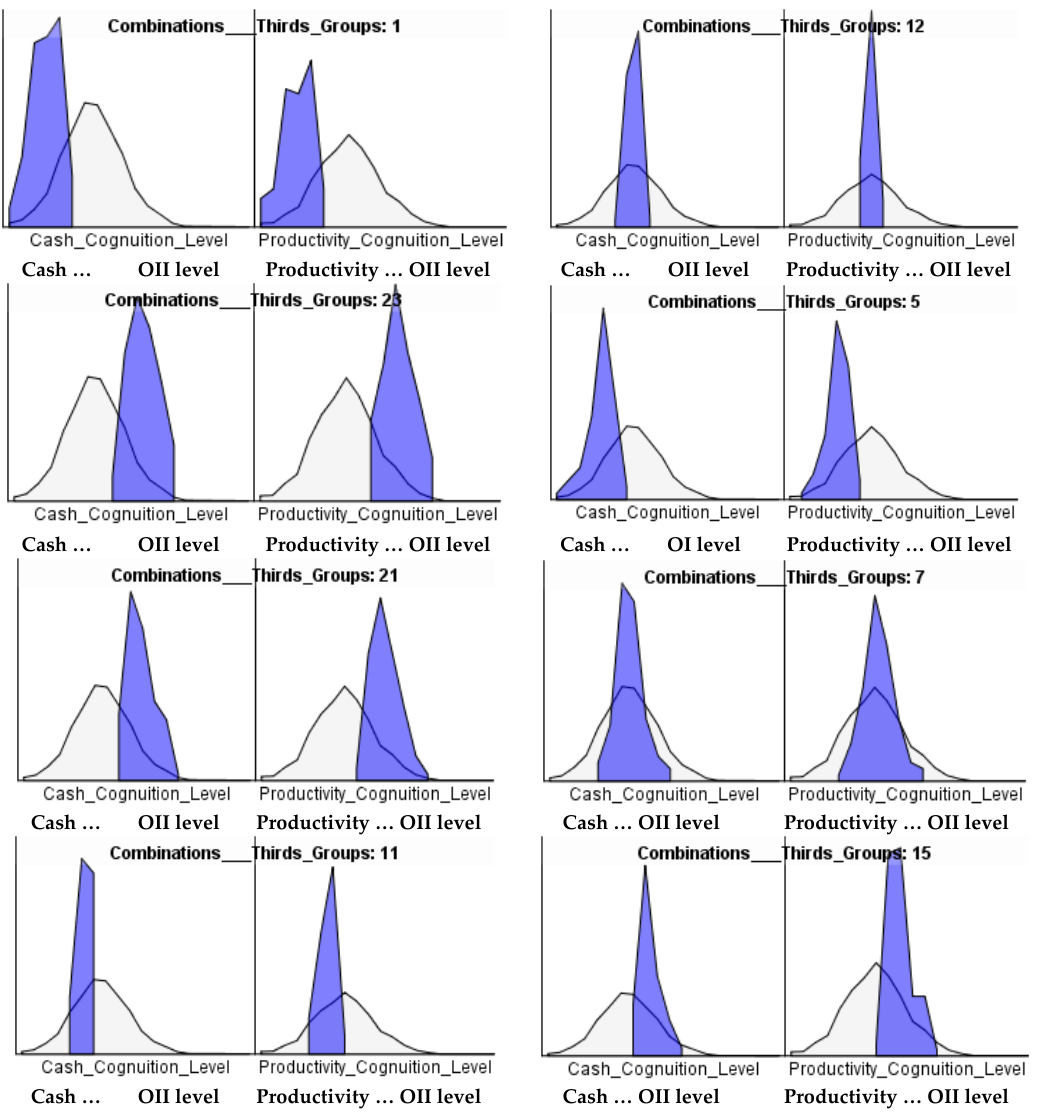
Figure 3. Frequency distributions of both the cash based and productivity based ‘objectively informed intuition’ (OII) variables (clear black line curves) relative to their distributions (shaded) for ranges of the BRphenotype, training and experience variables divided into thirds (the number on each sub graph reflects the combinations). For each group of the BRphenotype, training and experience variable levels, respectively: 1 = low, low, low combination; 12 = medium, medium, medium combination; 23 = high, high, high combination; 5 = low, low, high combination; 21 = high, high, medium combination; 7 = low, high, high combination; 11 = medium, low, medium combination; 15 = medium, high, high